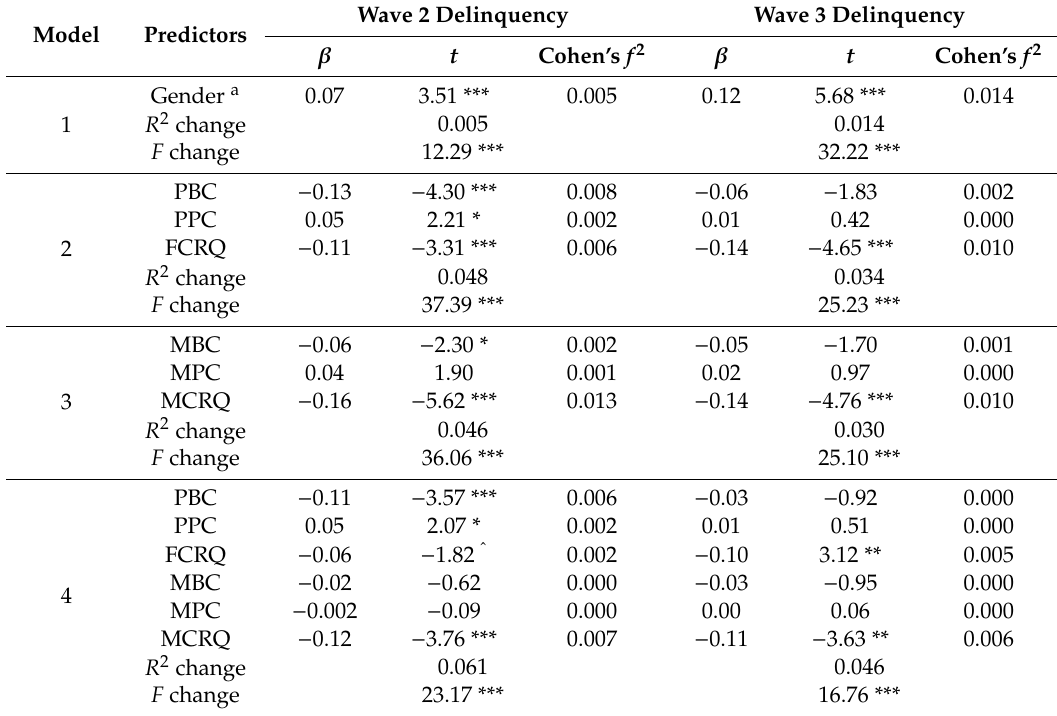
Table 9. Longitudinal predicting e ff ects of the parent-child subsystem qualities on delinquency.